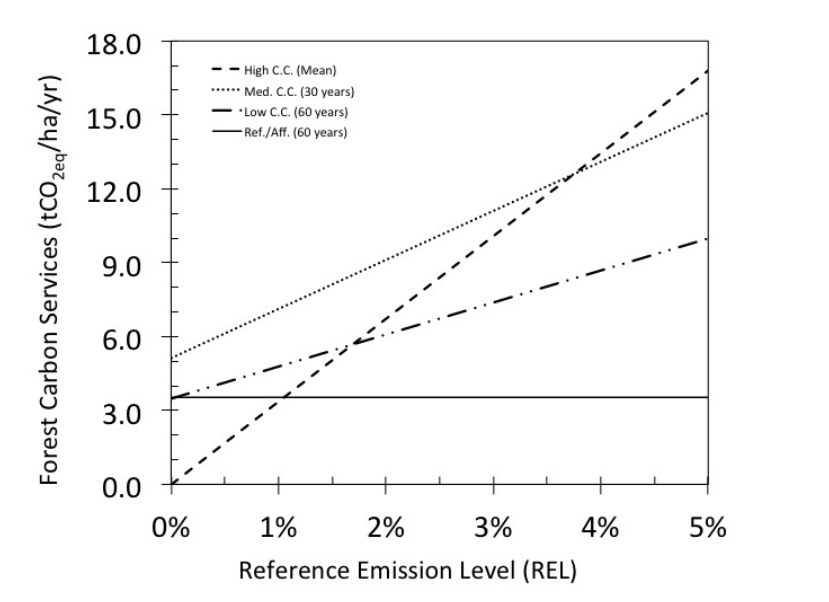
Figure 4. Potential forest carbon services in La Primavera as a function of the REL (considering mean values for carbon stocks and potential